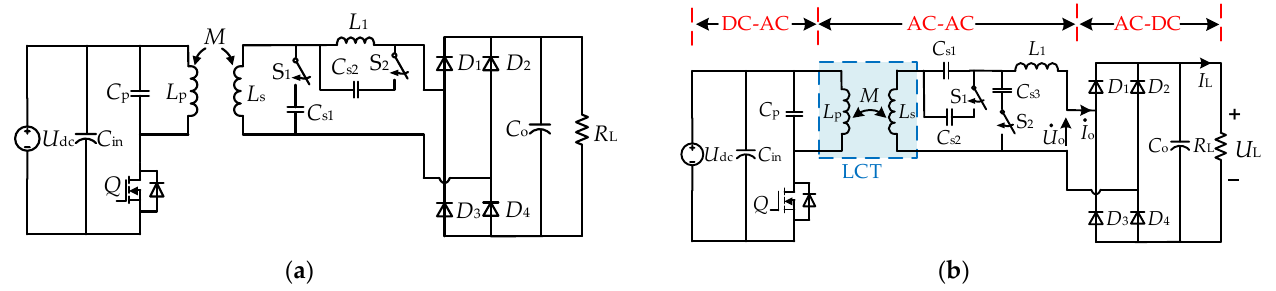
Figure 4. Hybrid topology of single-switch circuit. ( a ) The hybrid P-LC or P-S compensation network; ( b ) the proposed hybrid P-LCC or P-S compensation network.